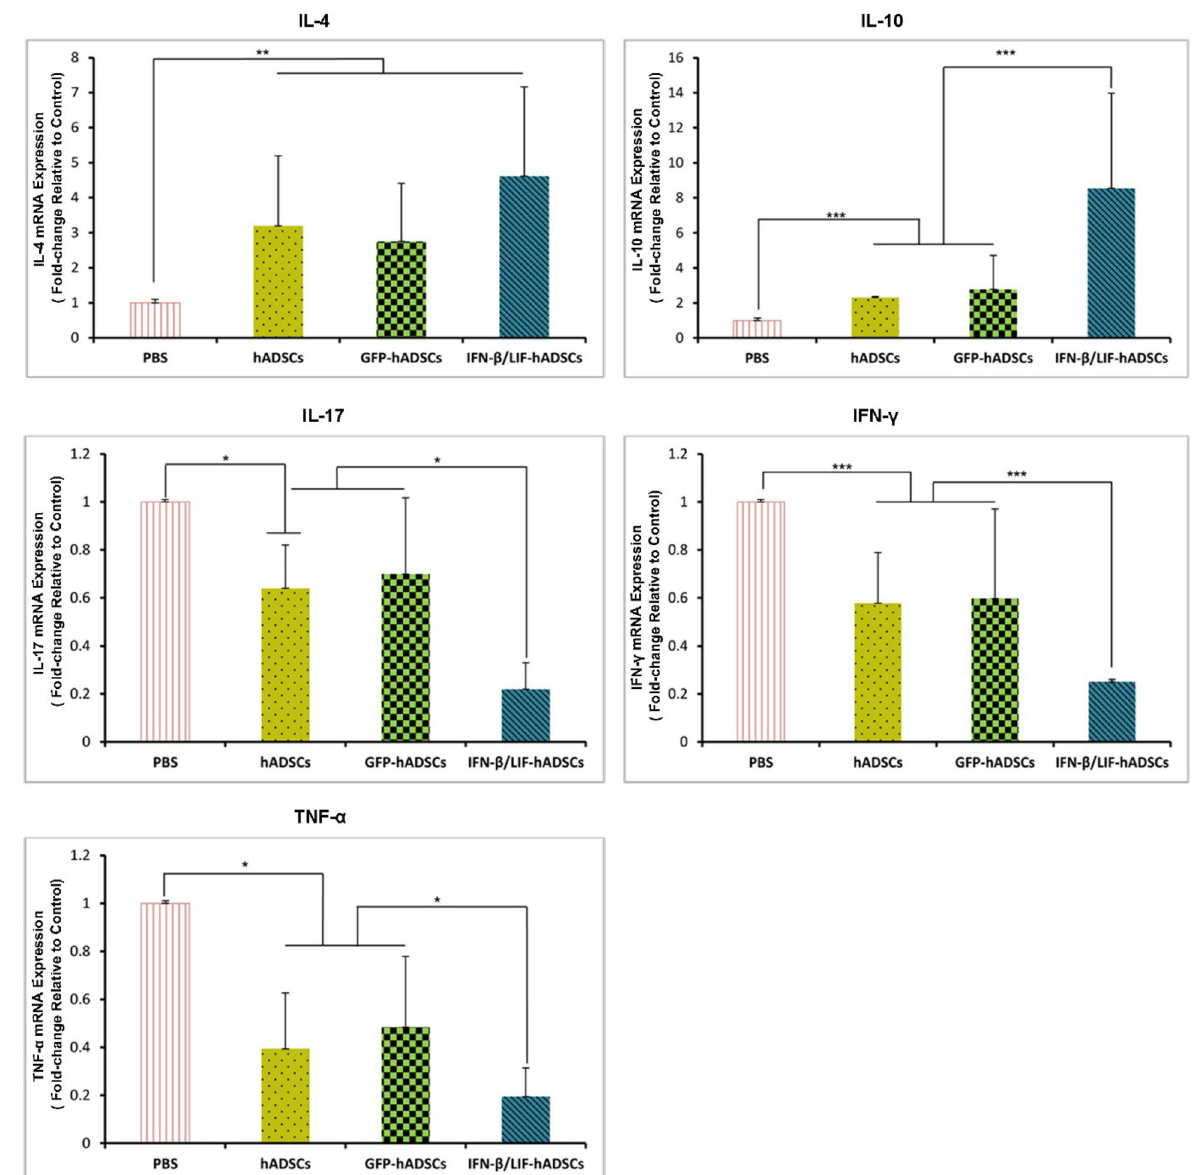
Figure 8. Cellular treatment affected the differential expression of pro/anti-inflammatory cytokine genes in CNS experimental groups. Quantitative RT- PCR data from spinal cord homogenates showed significant downregulation of pro-inflammatory cytokines (IL- 17, IFN -γ , and TNF -α) and upregulation of anti- inflammatory cytokines (IL-4 and IL-10) in the treated groups compared to an untreated group that was very prominent in IFN-β/LIF-hADSCs group. (The results are shown as mean ± SEM of three animals, * P < 0.05, ** P < 0.01, *** P < 0.001 (One-way ANOVA).IL-4:(F3,8 = 17.761, P = 0.001), IL-10:(F3,8 = 33.937, P = 0.000) IL-17:(F3,8 = 4.250, P = 0.045), IFN –γ:(F3,8 = 197.041, P = 0.000), TNF –α:(F3,8 = 4.570, P =